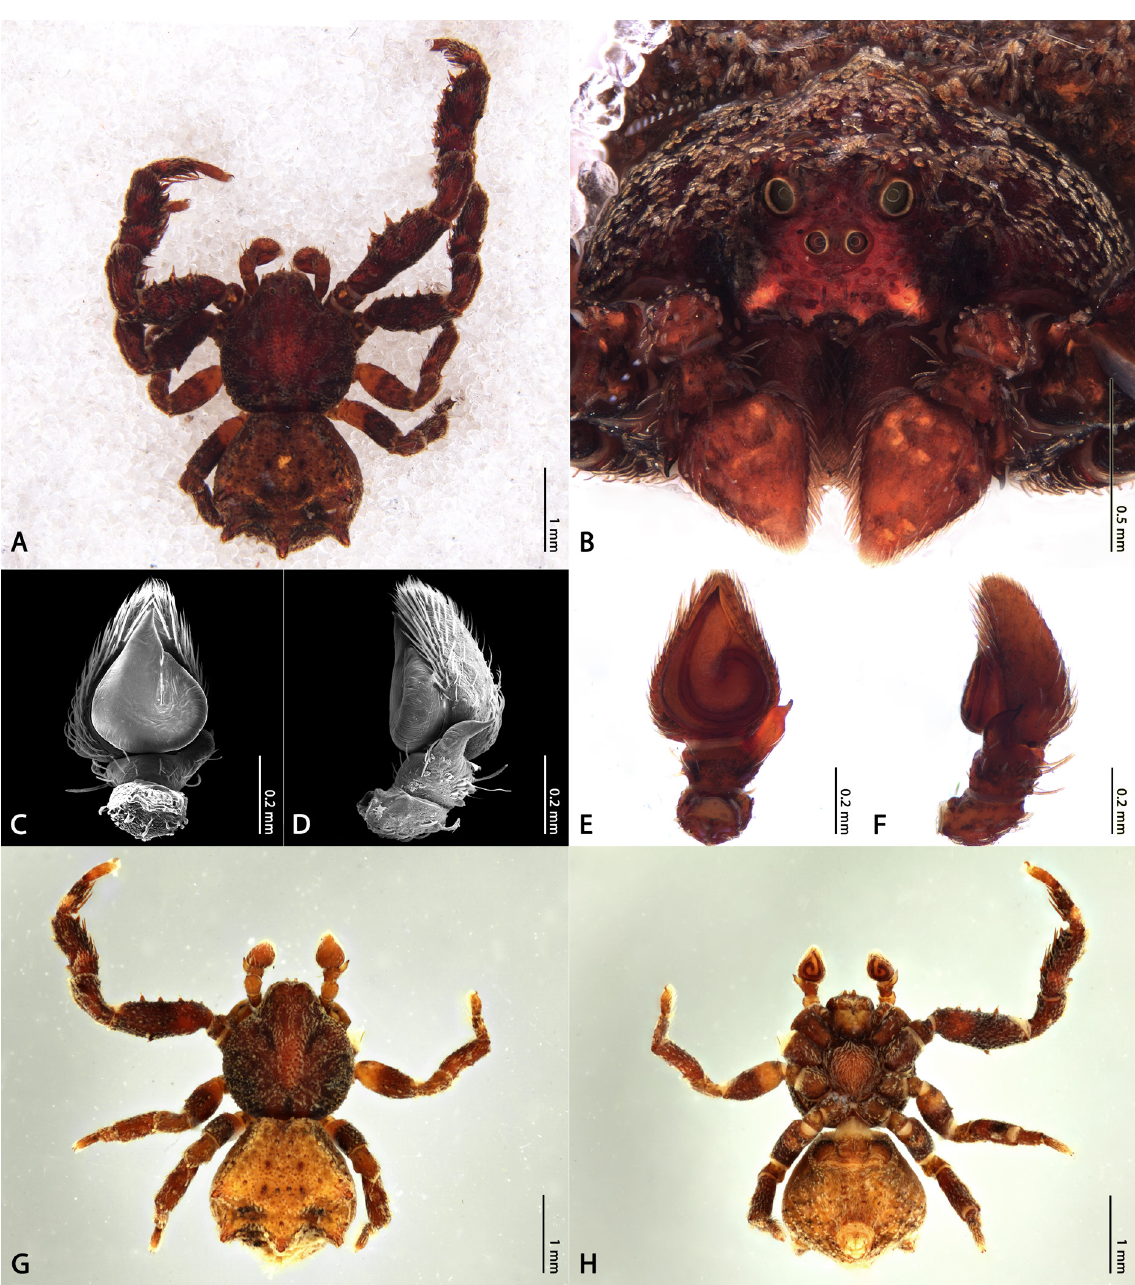
Fig. 14. Male of Kryptochroma quinquetuberculata (Taczanowski, 1872) gen. et comb. nov. A–F . Specimen IBSP 46712. A . Habitus, dorsal view. B . Front. C–F . Left male palp. C, E . Ventral view. D, F . Retrolateral view. G–H . Neotype of K. quinquetuberculata gen. et comb. nov.